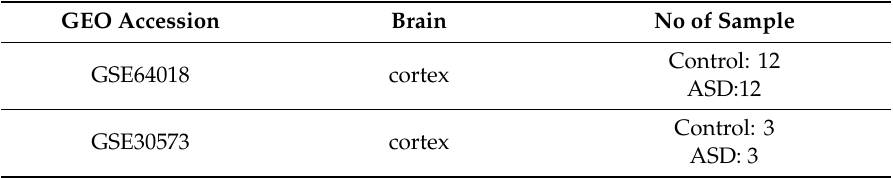
Table 1. Characteristics of datasets employed in the